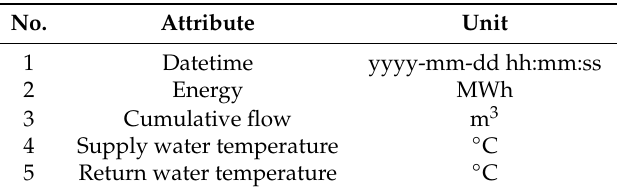
Table 2. The measured attributes of data on the primary side.